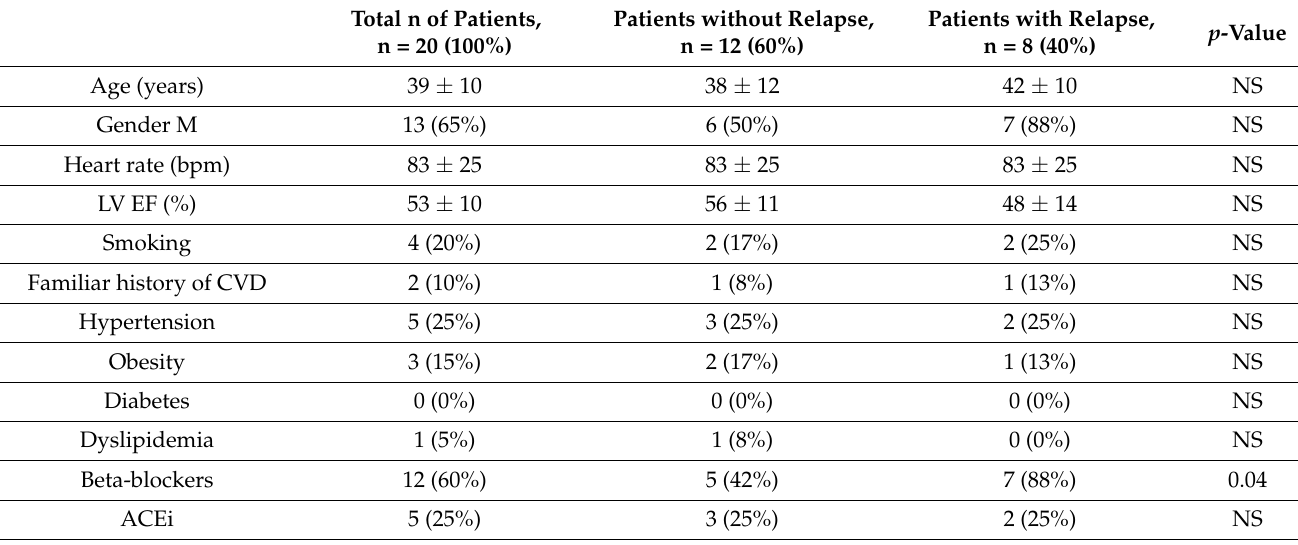
Table 2. Clinical characteristics of the study